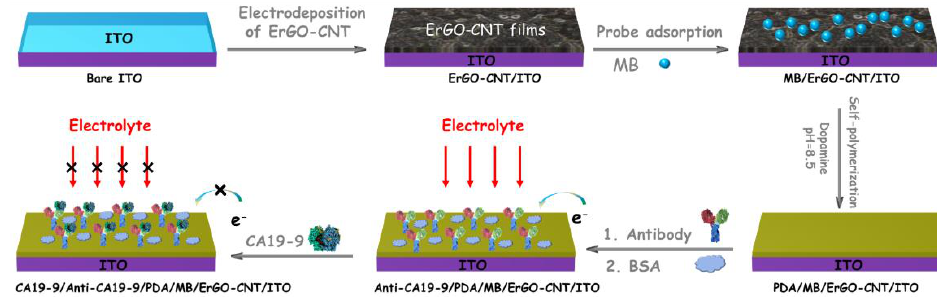
Figure 1. Schematic illustration for the label-free electrochemical determination of CA19-9.